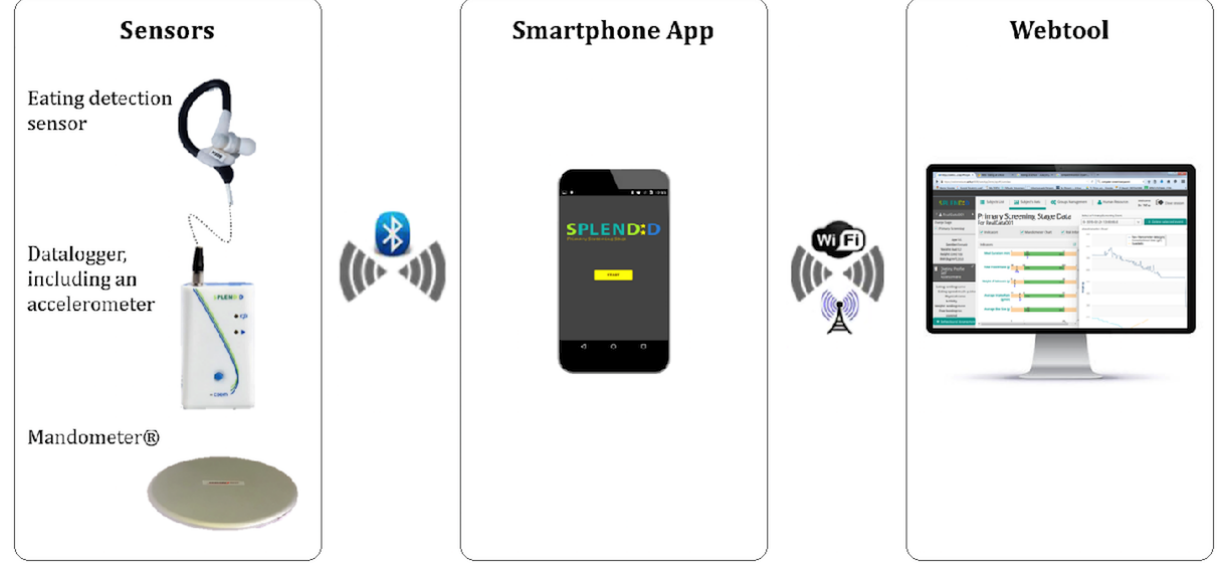
Figure 1. The SPLENDID eating detection sensor integrated into the full SPLENDID system. This system combines the eating detection sensor with